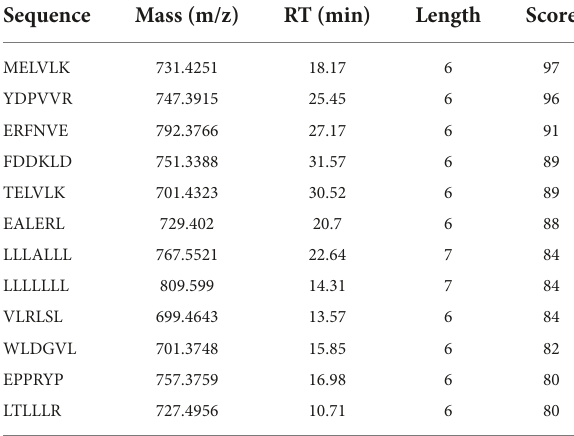
FIGURE4 Results of ACE inhibitory activity of peptides after ultrafiltration. Means denoted by a different letter indicate significant differences between treatments ( P < 0.05). FHMP-I ( < 5 kDa), FHMP-II (3–5 kDa), FHMP-III ( < 3 kDa), FHMP-IV (1–3 kDa), FHMP-V ( < 1 kDa).